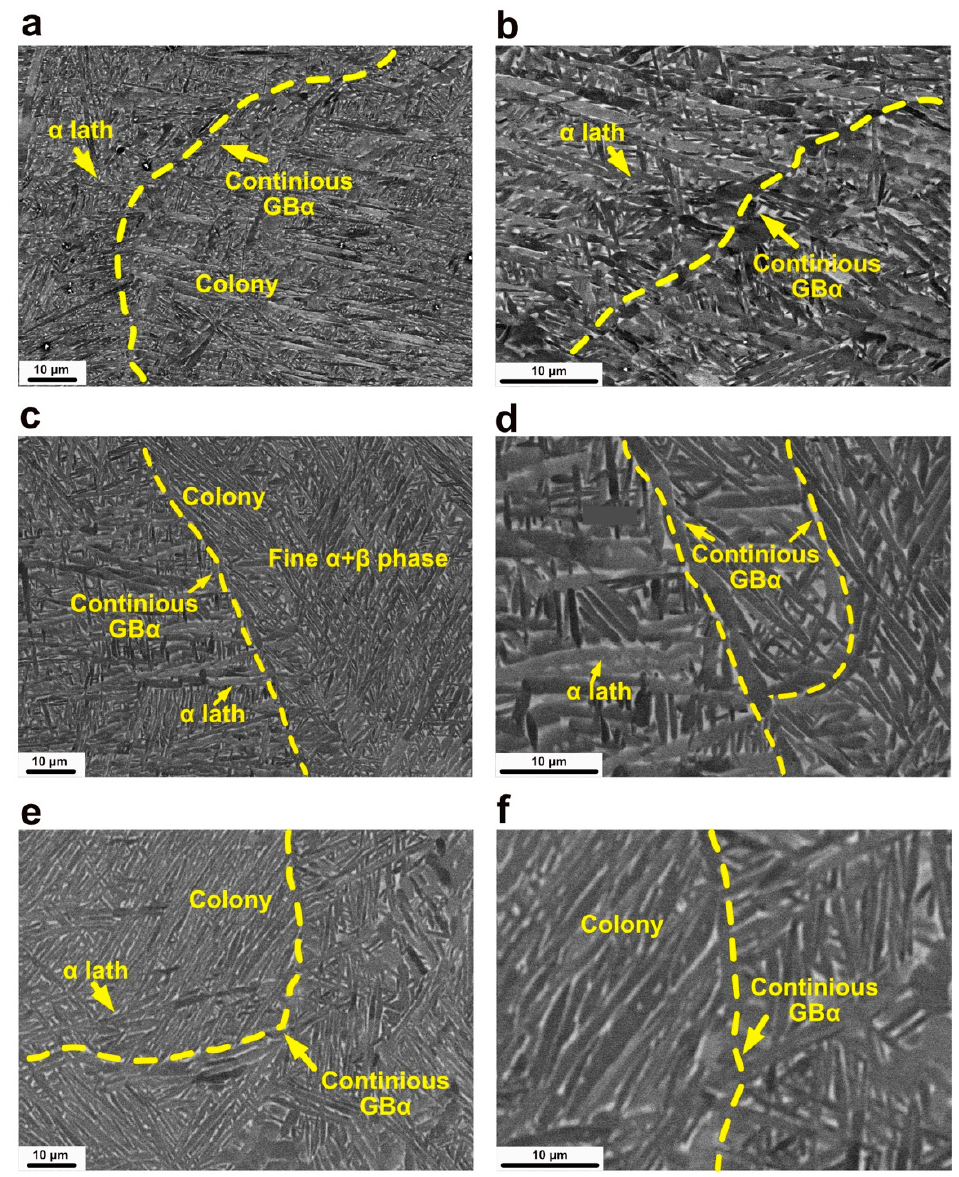
Figure 8. Microstructures in SLMed Ti64 with the different heat treatments, ( a , b ) 850-WQ, ( c , d ) 850-AC, ( e , f ) 850-FC.